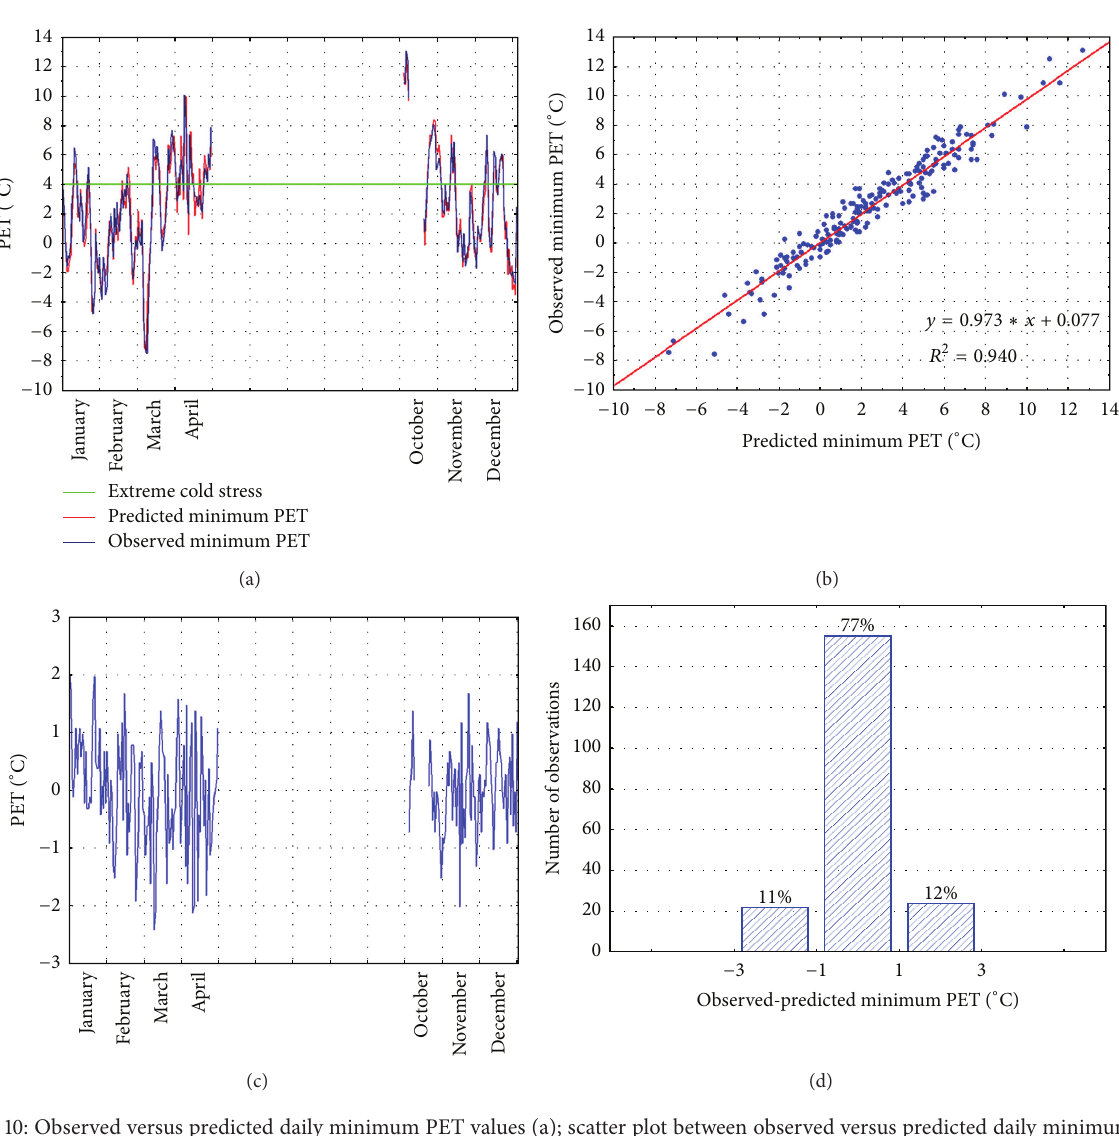
period of the year present extreme cold stress (PET < 4.0 ∘